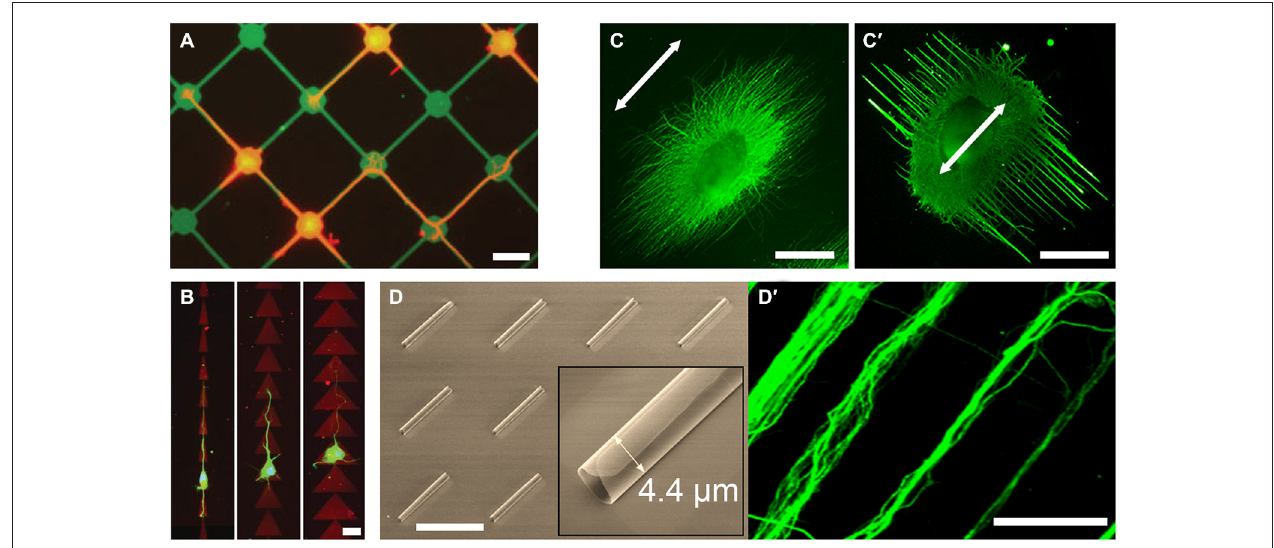
Chemistry. (C,C (cid:48) ) Chick dorsal root ganglia (DRG; stained for neurofilaments; green) cultured on electrospun poly-( ε -caprolactone) nanofiber gels with different fiber collection times and support substrates, but with the same fiber alignment (arrow). Adapted with permission from Xie et al. (2014). (D) Scanning electron micrograph of the self-rolled-up silicon nitride microtubes array and (D (cid:48) ) aligned bundles of mouse cortical axons (stained for tubulin; green). Adapted with permission from Froeter et al. (2014). Copyright 2014 American Chemical Society. Scale bars = 20 µ m (A,B) , 1 mm (C) , 50 µ m (D)